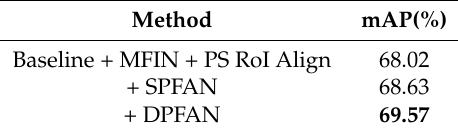
Table 5. Different feature attention network configurations. DPFAN represents our proposed Double-Path Feature Attention Network. SPFAN represents a single branch of DPFAN. The numbers in boldface indicate the best performance.